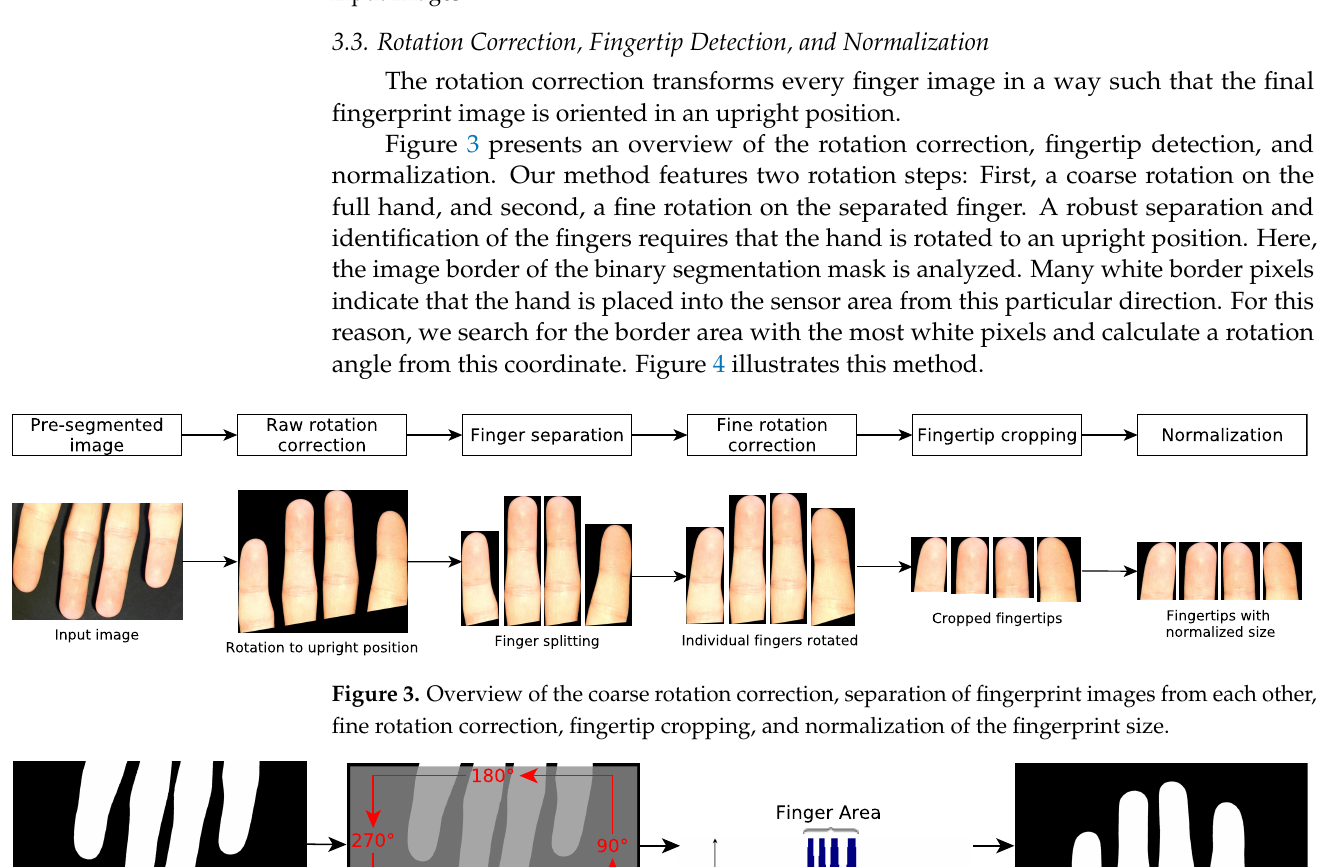
Figure 2. Overview of the segmentation of connected components from a continuous stream of input images.